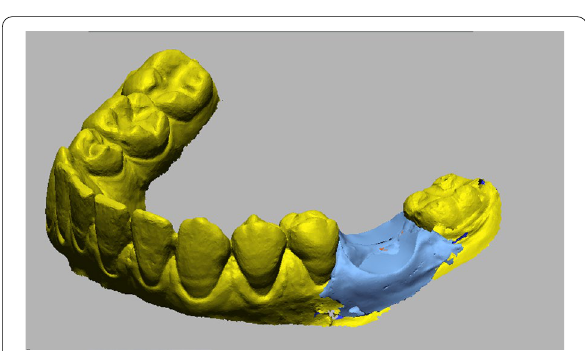
Fig. 6 Buccal view showing the change of the soft tissue volume after tooth